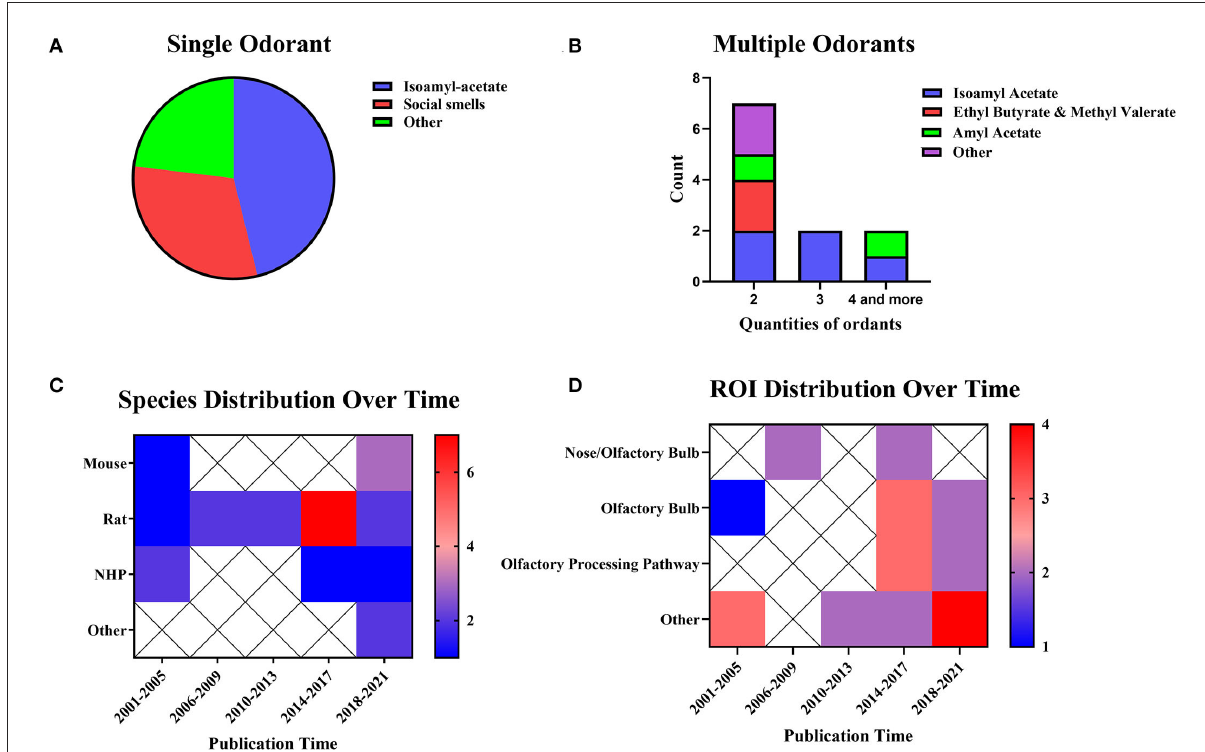
FIGURE5 Odorants, species distribution, and ROI distributions. (A) Studies using single stimuli (n = 13, 54.17%). (B) Studies using multiple stimuli (n = 11, 45.83%). The color bar means the number of studies. (C) Temporal distribution of experimental animals. (D) Distribution of ROI over time. The color bar means the number of